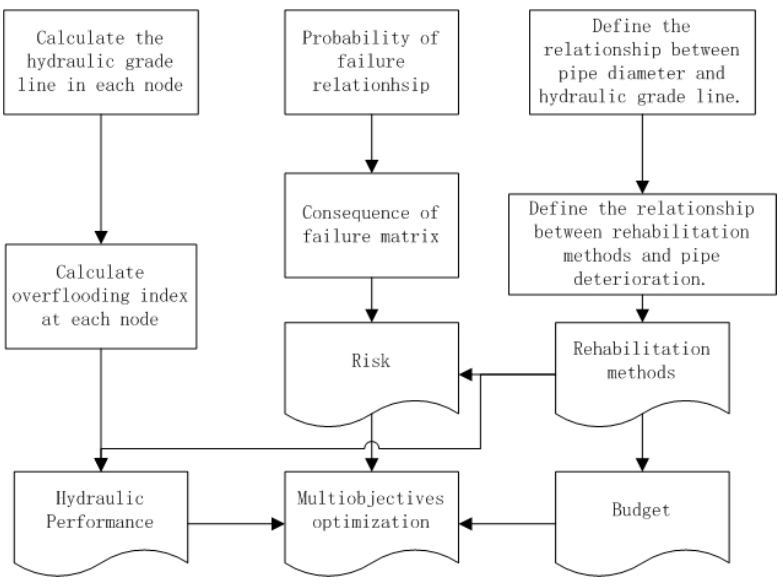
Figure 3. Diagram of the revised framework (RHRCM).